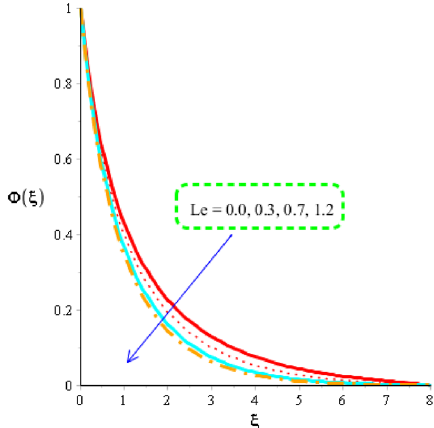
Figure 13. Distribution in �(ξ) versus Le .